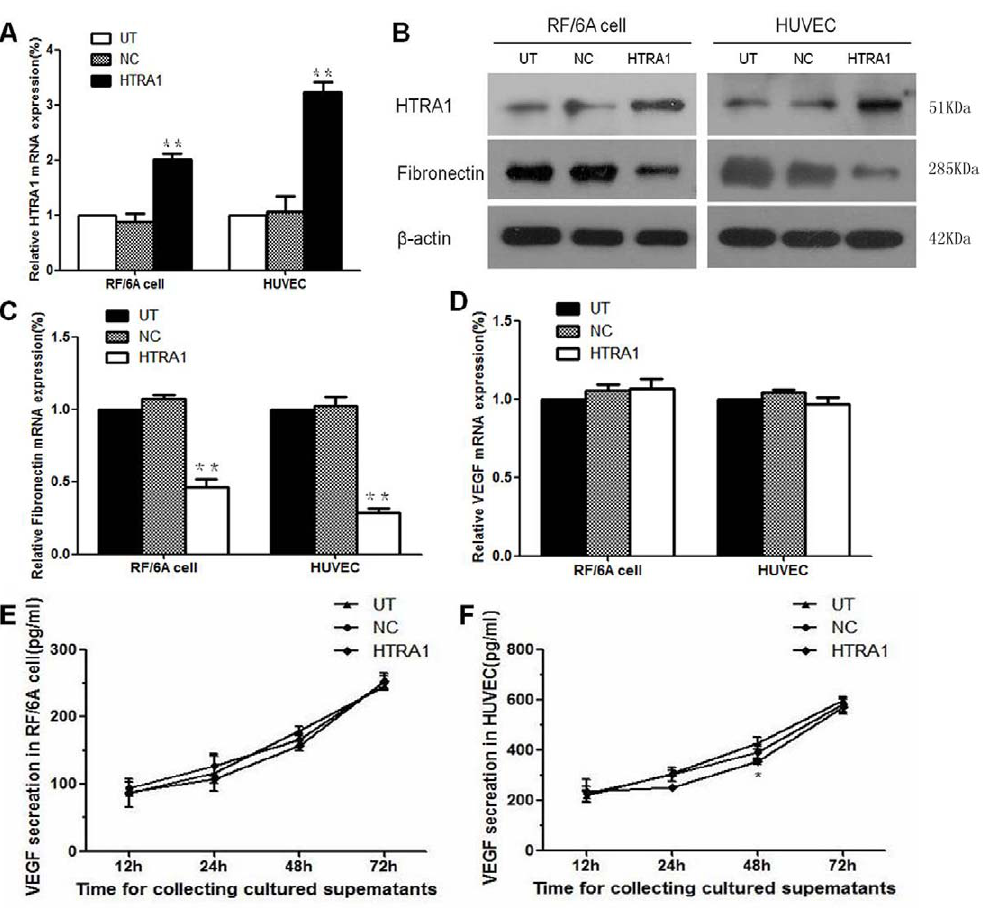
Figure 1. Effect of pGC-FU-3FLAG-HTRA1 on HTRA1, fibronectin and VEGF expression in RF/6A cells and HUVECs as determined by real-time RT-PCR and western blotting or ELISA. Messenger RNA (A) and protein (B) expression of HTRA1 in RF/6A cells and HUVECs transfected with pGC-FU-3FLAG-HTRA1 were increased when compared with the control groups (**P , 0.01). The fibronectin mRNA (C) and protein (B) levels were reduced in HTRA1-overexpressing cells (**P , 0.01), while no significant differences were noted in the expression levels of VEGF mRNA (D) and secreted protein, except for a slight decrease in protein levels in cultured HUVEC supernatants at 48 hours (*P , 0.05).